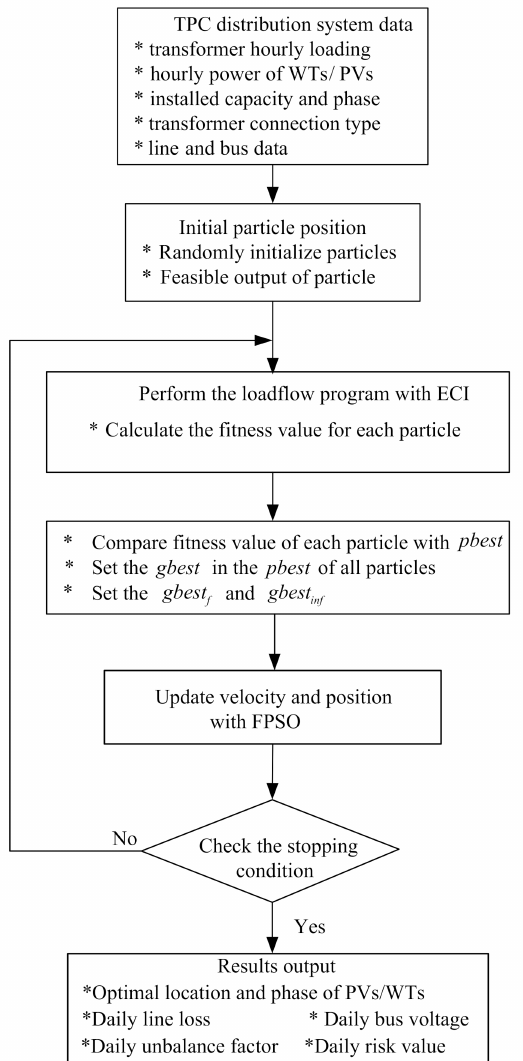
Figure 6. Flowchart of the searching